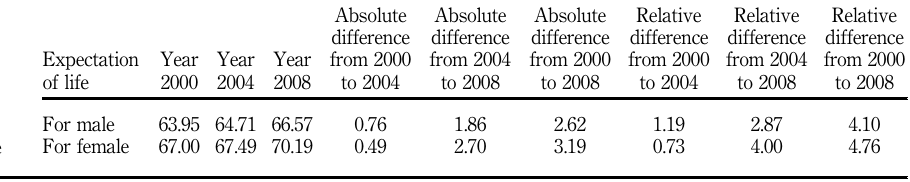
Table II. Life Expectancy in specified causes of deaths ( D α ) eliminating the effect of other causes of deaths for both sexes in different